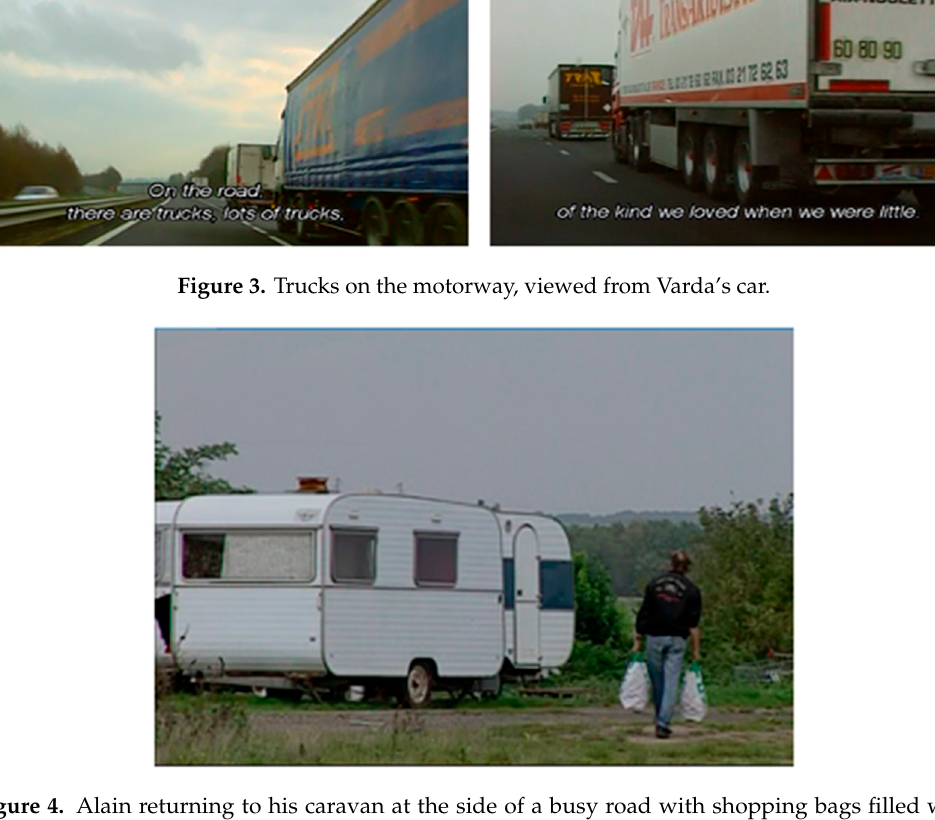
Figure 4. Alain returning to his caravan at the side of a busy road with shopping bags filled with potatoes he has gleaned from nearby fields .